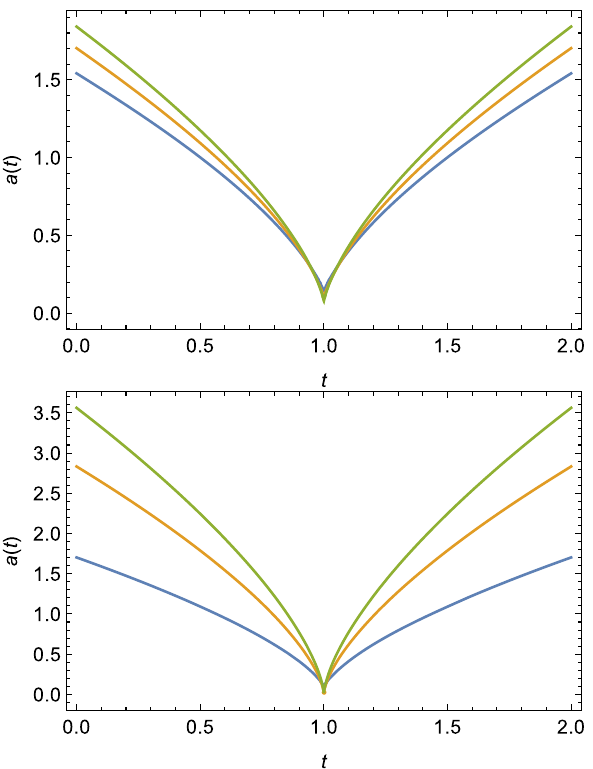
Fig. 7 Time evolution of the two-sphere for scalar-matter interaction. For the graph on top, the choice of ρ 0 is varied (blue curve ρ 0 = 7, yellow curve ρ 0 = 10, green curve ρ 0 = 13) while other parameters are kept fixed ( ψ 0 = a 0 = 0 . 1). For the graph on bottom, the choice of ψ ψ = 0 . 1, yellow curve ψ = 0 . 5, green curve 0 is varied (blue curve 0 0 ψ = 1) while other parameters ar kept fixed ( ρ = 10 , a = 0 . 0 0 0